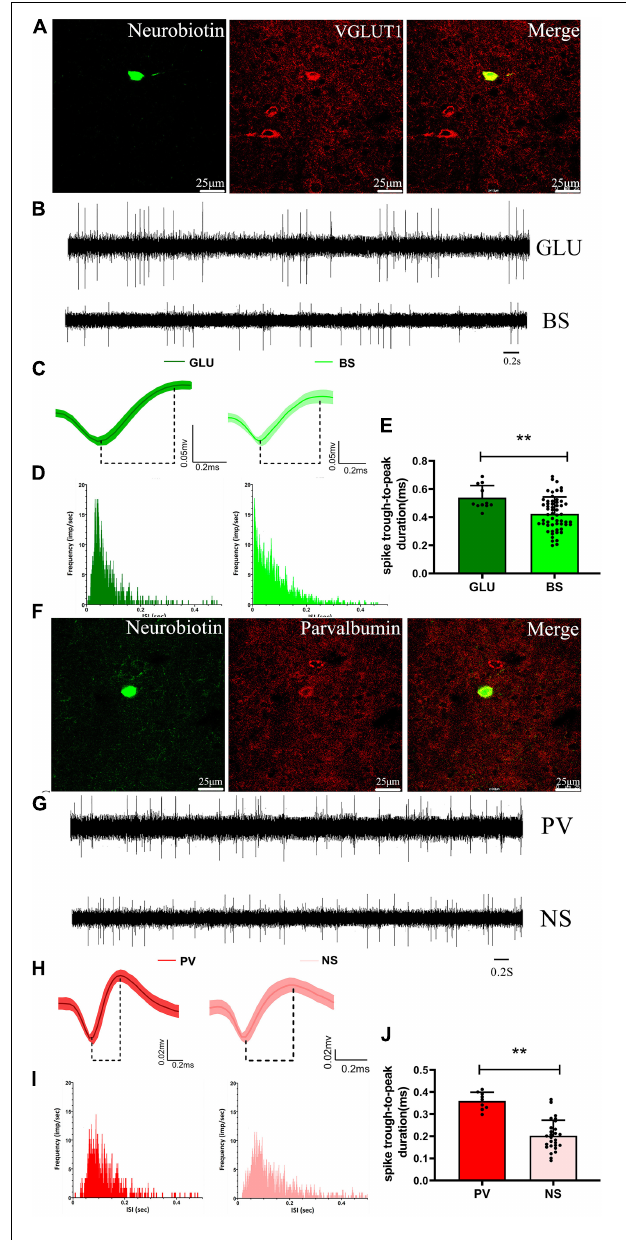
FIGURE 6 | Identified neurochemical and electrophysiological properties of M1 neurons and comparison with microwire electrode characteristics. A representative fluorescent image of immuno-labeled GLU-positive neuron in the M1 (A) , and of immuno-labeled parvalbumin-positive neuron in the M1 (F) . Compare example of (B) baseline firing properties of (C) average extracellular waveform and (D) ISI distribution for the labeled GLU-positive neuron and microwire electrode recording BS neurons, respectively. Compare example of (G) baseline firing properties of (H) average extracellular waveform and (I) ISI distribution for the labeled parvalbumin-positive neuron and microwire electrode recording NS neurons, respectively. A significant difference in spike duration (trough-to-peak measure) both for the (E) GLU-positive neuron with BS and the (J) parvalbumin-positive neuron with NS neurons, respectively. ** p <